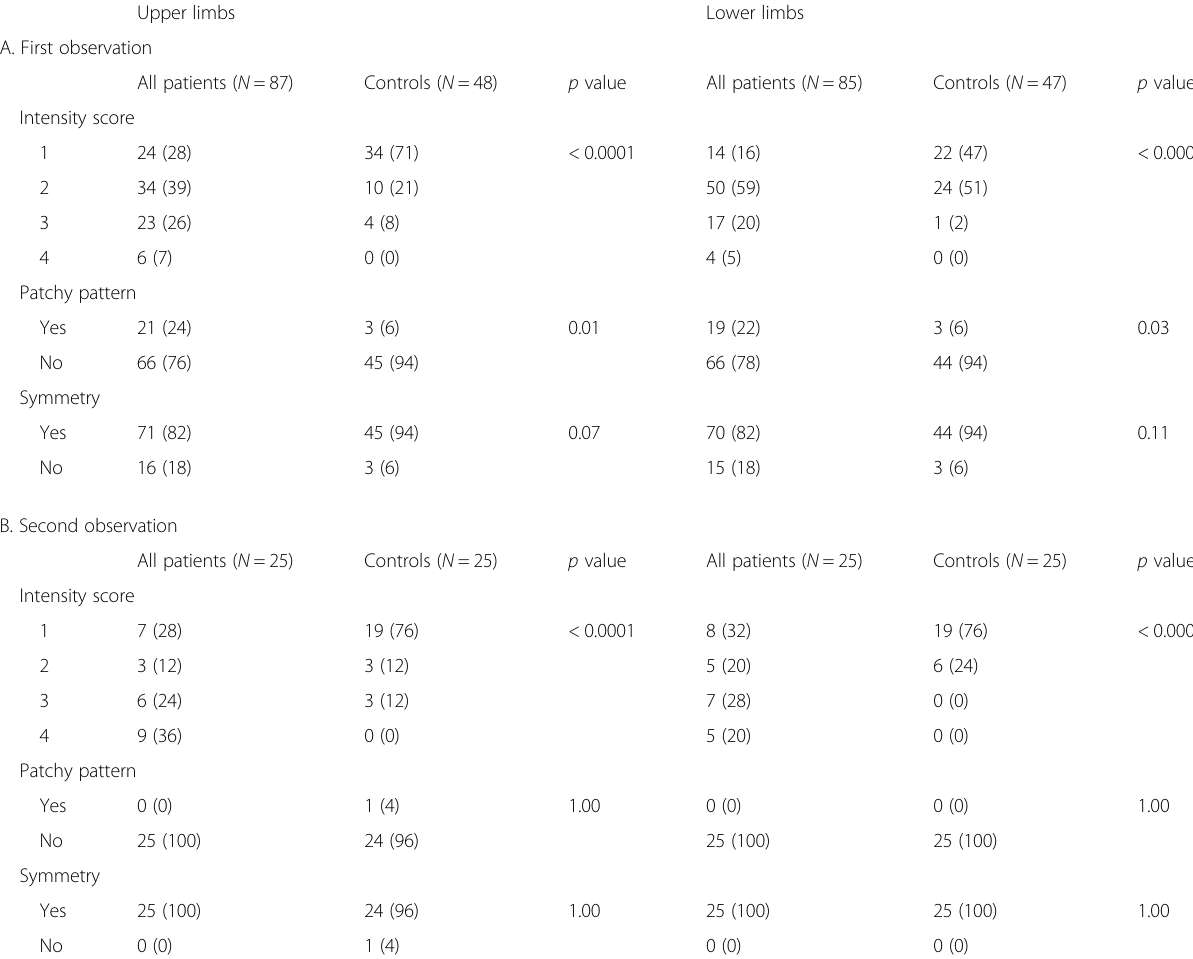
Table 2 Qualitative parameters of 99m Tc-PYP muscular uptake in patients with polymyositis or dermatomyositis and control persons Upper